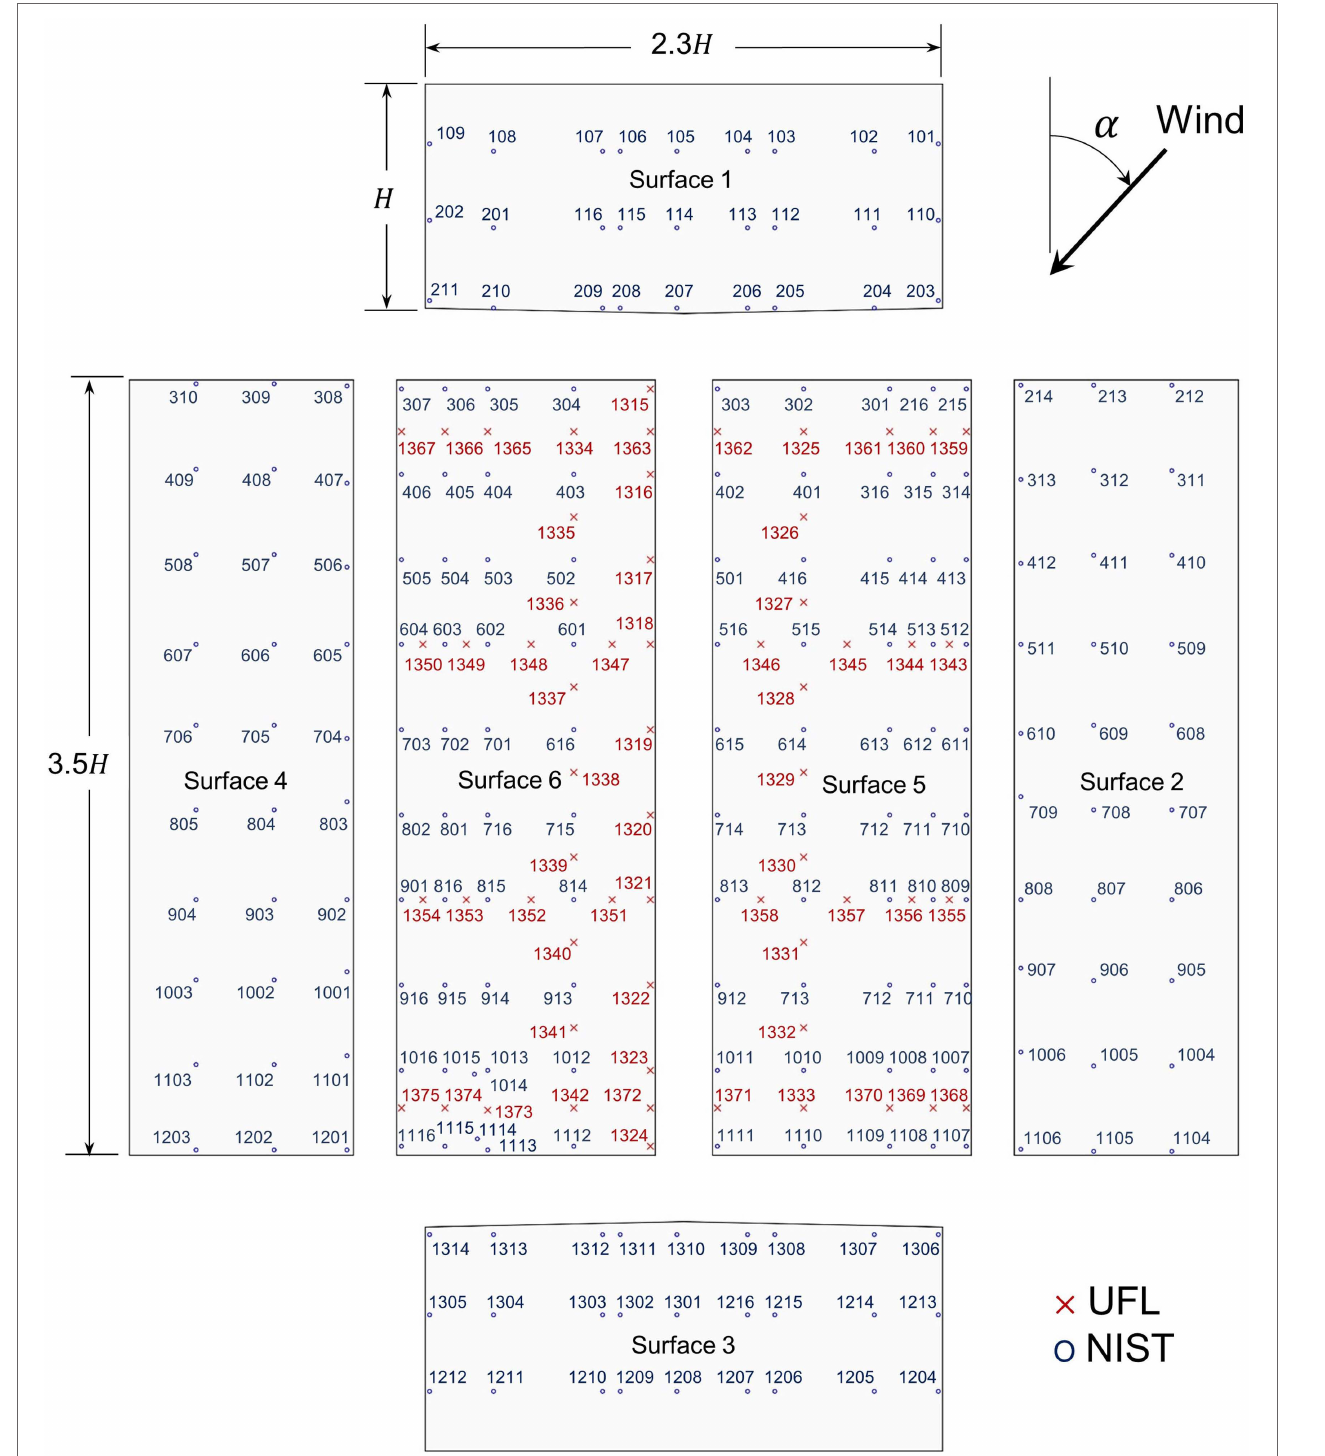
FIGURE 5 | Tap layout for the 1:20 Wind Engineering Research Field Laboratory model. Tap location is identical to building model “st3” in the NIST aerodynamic database (Ho et al., 2003) with the exception of the additional taps indicated by the “X” marker.